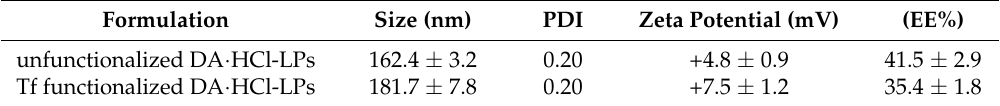
Table 1. Particle size ± SD, polydispersity index (PDI), zeta potential, and percent of